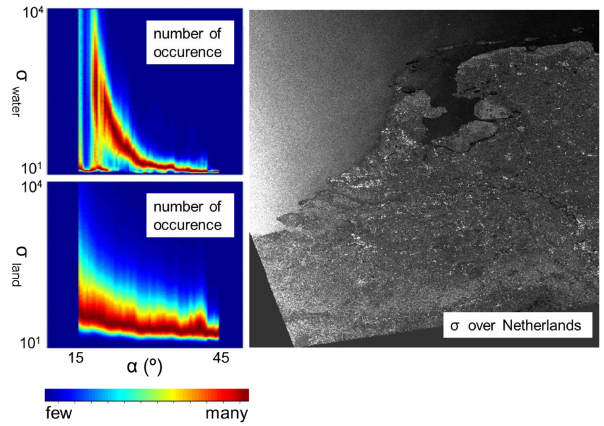
Fig. 2. Trained and gaussian smoothed 2-D histograms for land and water (left panel) as derived from two years of ASAR WSM backscatter data in the Netherlands (right